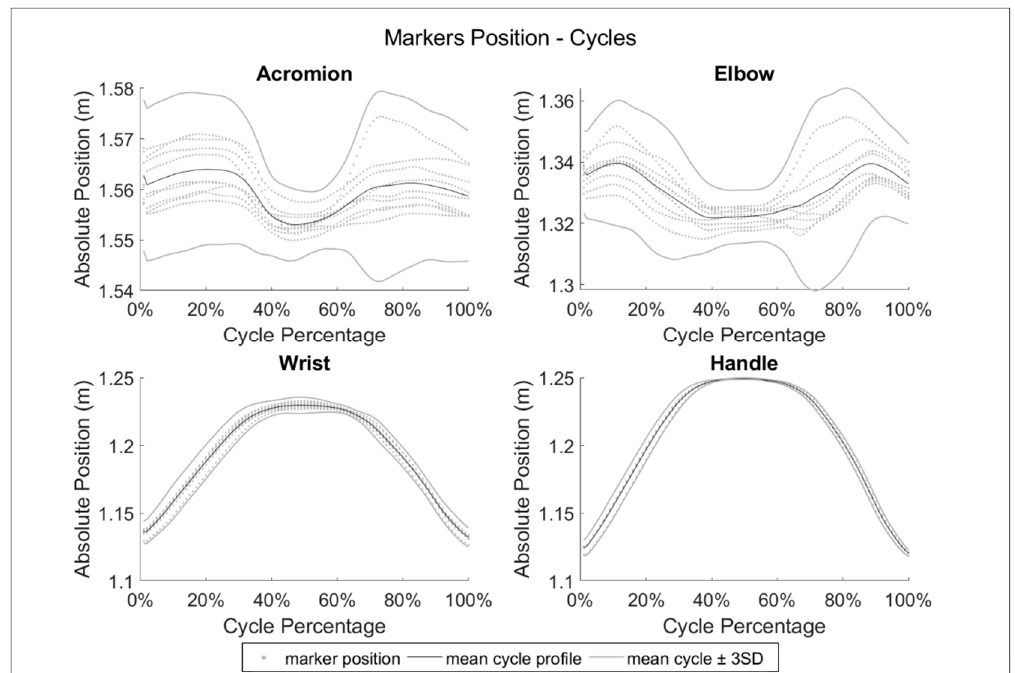
Figure 5. Repeatability of the joints movement for the example Session C; from left to right, up to down, the displacement of the marker on acromion, elbow, wrist and handle.